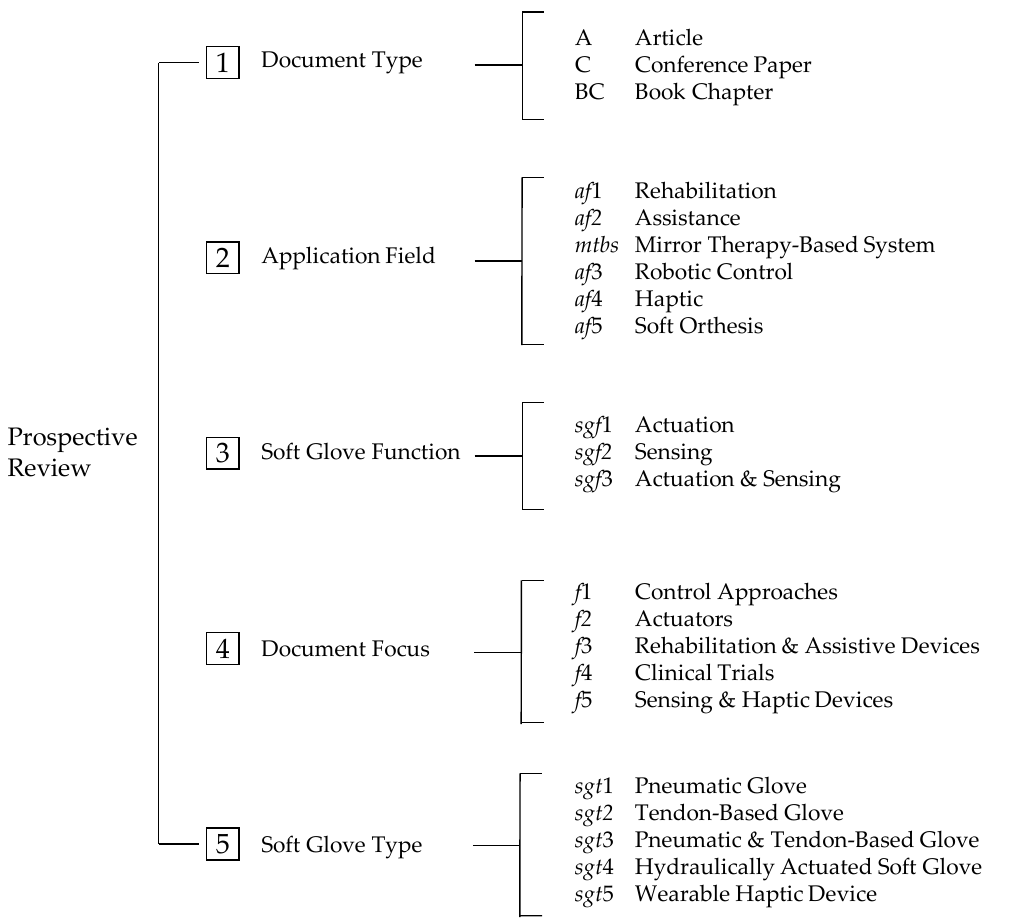
Figure 5. Adopted taxonomy for the prospective